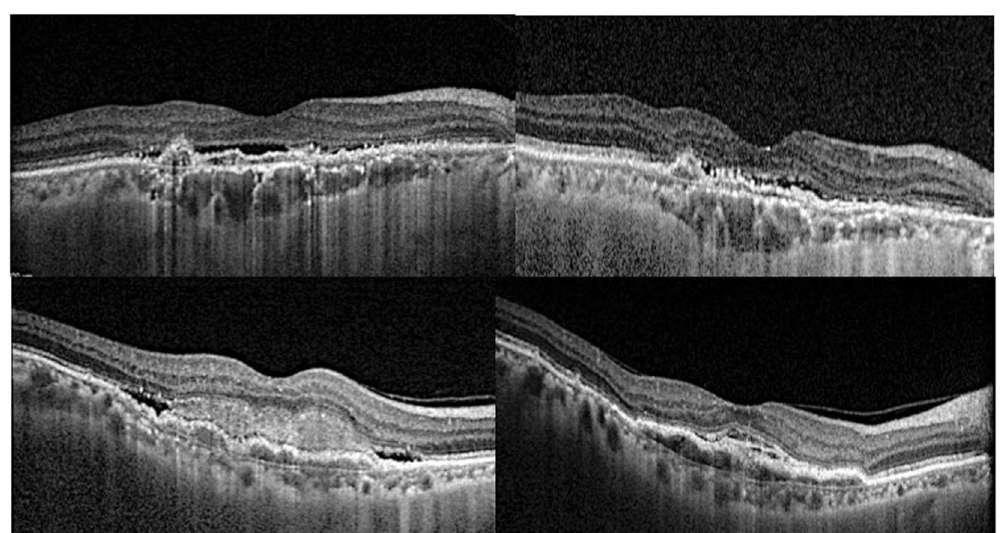
Figure 2. The choroidal vascularity index (CVI), total choroidal area (TCA), luminal area (LA) and stromal area (SA) changes of neovascular age-related macular degeneration eyes with upper and lower CVI tertile from baseline to month 12. ( A , top left) Baseline OCT in an eye within the highest baseline CVI tertile (CVI: 67.8%; LA: 2.10 mm 2 ; SA: 1.0 mm 2 ). Dilated Haller’s layer vessels and relative compression of choroidal stroma can be appreciated. At month 12 ( B , top right), there was reduction in CVI and luminal area (CVI: 58.4%; LA: 1.45 mm 2 ; SA: 1.18 mm 2 . ( C , bottom left) Baseline OCT in an eye within the lowest baseline CVI tertile (CVI: 57.7%; TCA: 2.98 mm 2 ; LA: 1.72 mm 2 ; SA: 1.26 mm 2 ). The Haller’s layer vessels are less dilated compared to ( A ) that lies within the highest tertile. At month 12 ( D , bottom right), there was an increase in CVI due to significant reduction in SA compared to LA (CVI: 65.3%; TCA: 2.41 mm 2 ; LA: 1.57 mm 2 ; SA: 0.84 mm 2 ).